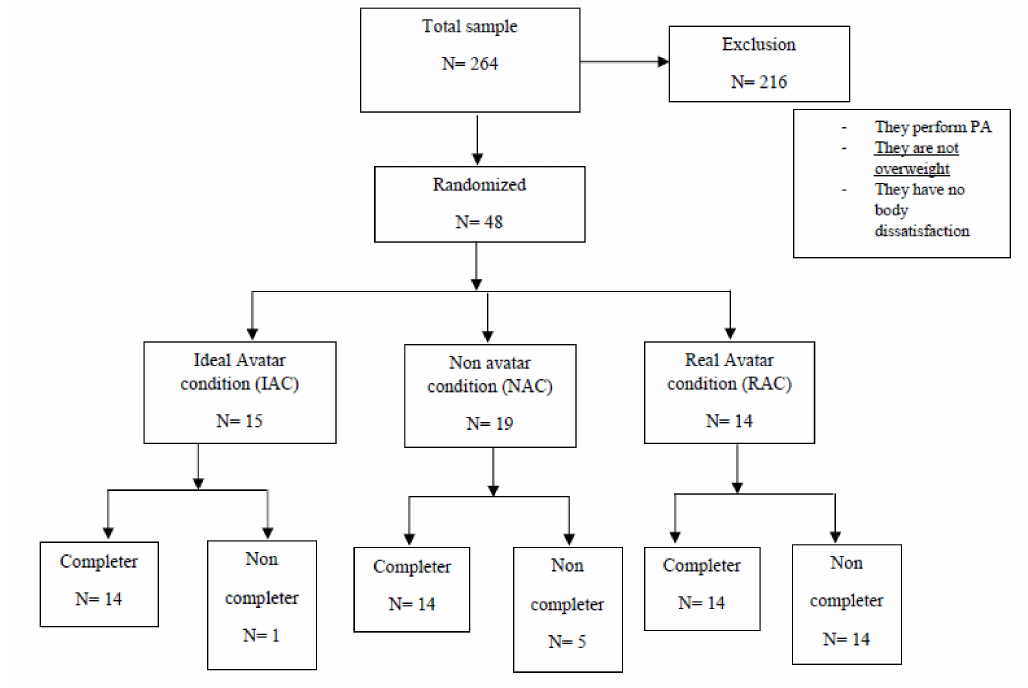
Figure 1. Flow chart of participants’